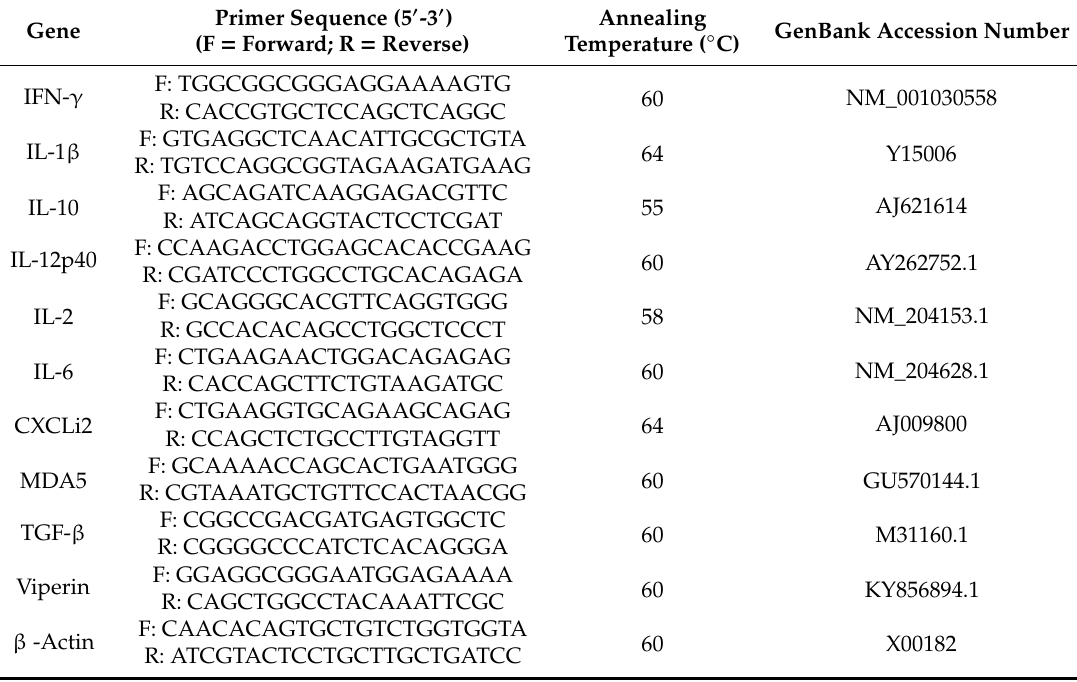
Table 1. Primer sequences used for real-time quantitative